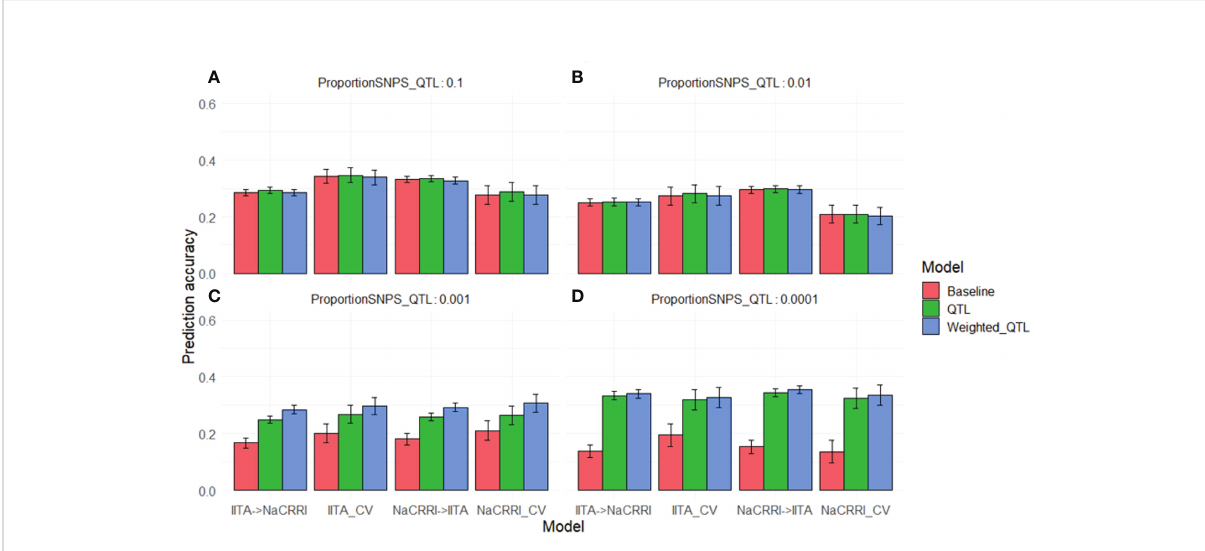
FIGURE 5 Genomic Prediction Accuracies with Simulated QTL. Prediction accuracies are shown on the y-axis as the correlation between predicted andtrue breeding values. The x-axis delineates the prediction scenario being tested. Barplot color corresponds to the genomic information used in the prediction model. Error bars represent a 95% con fi dence interval for simulations. Simulations were repeated with different proportions of the markers acting as causative QTL: 0.1 (A) , 0.01 (B) , 0.001 (C) , and 0.0001 (D) .